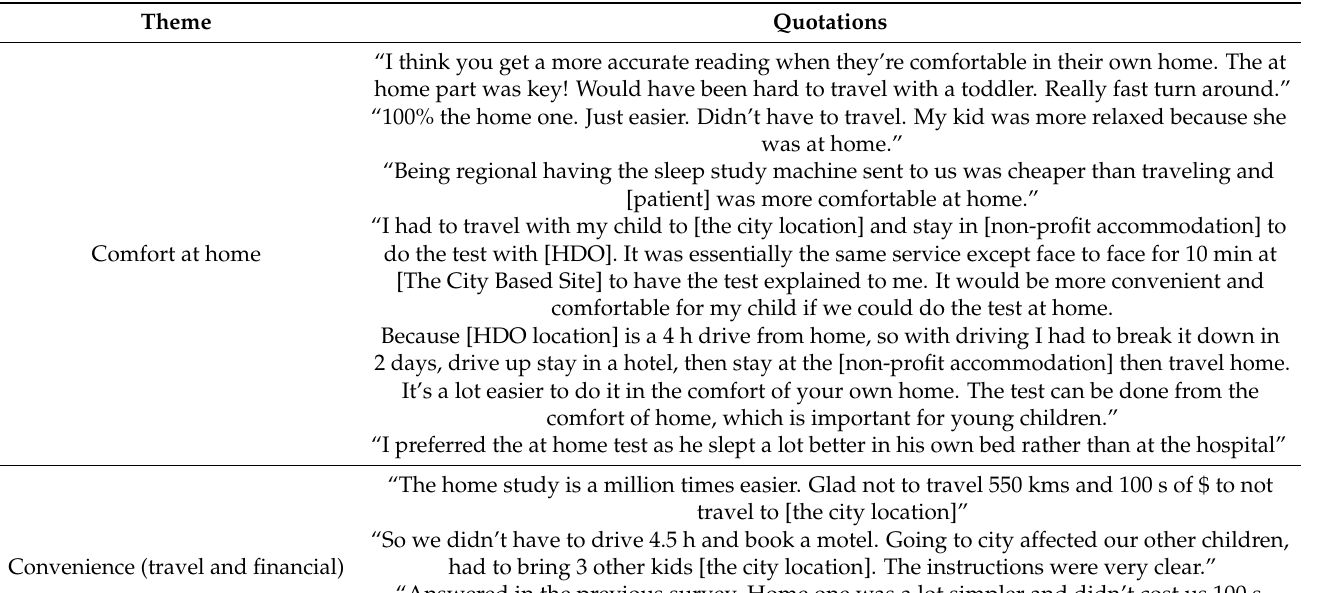
Table 3. Thematic analysis of qualitative. The themes identified in the qualitative data included comfort at home, convenience (financial and distance), and HDO